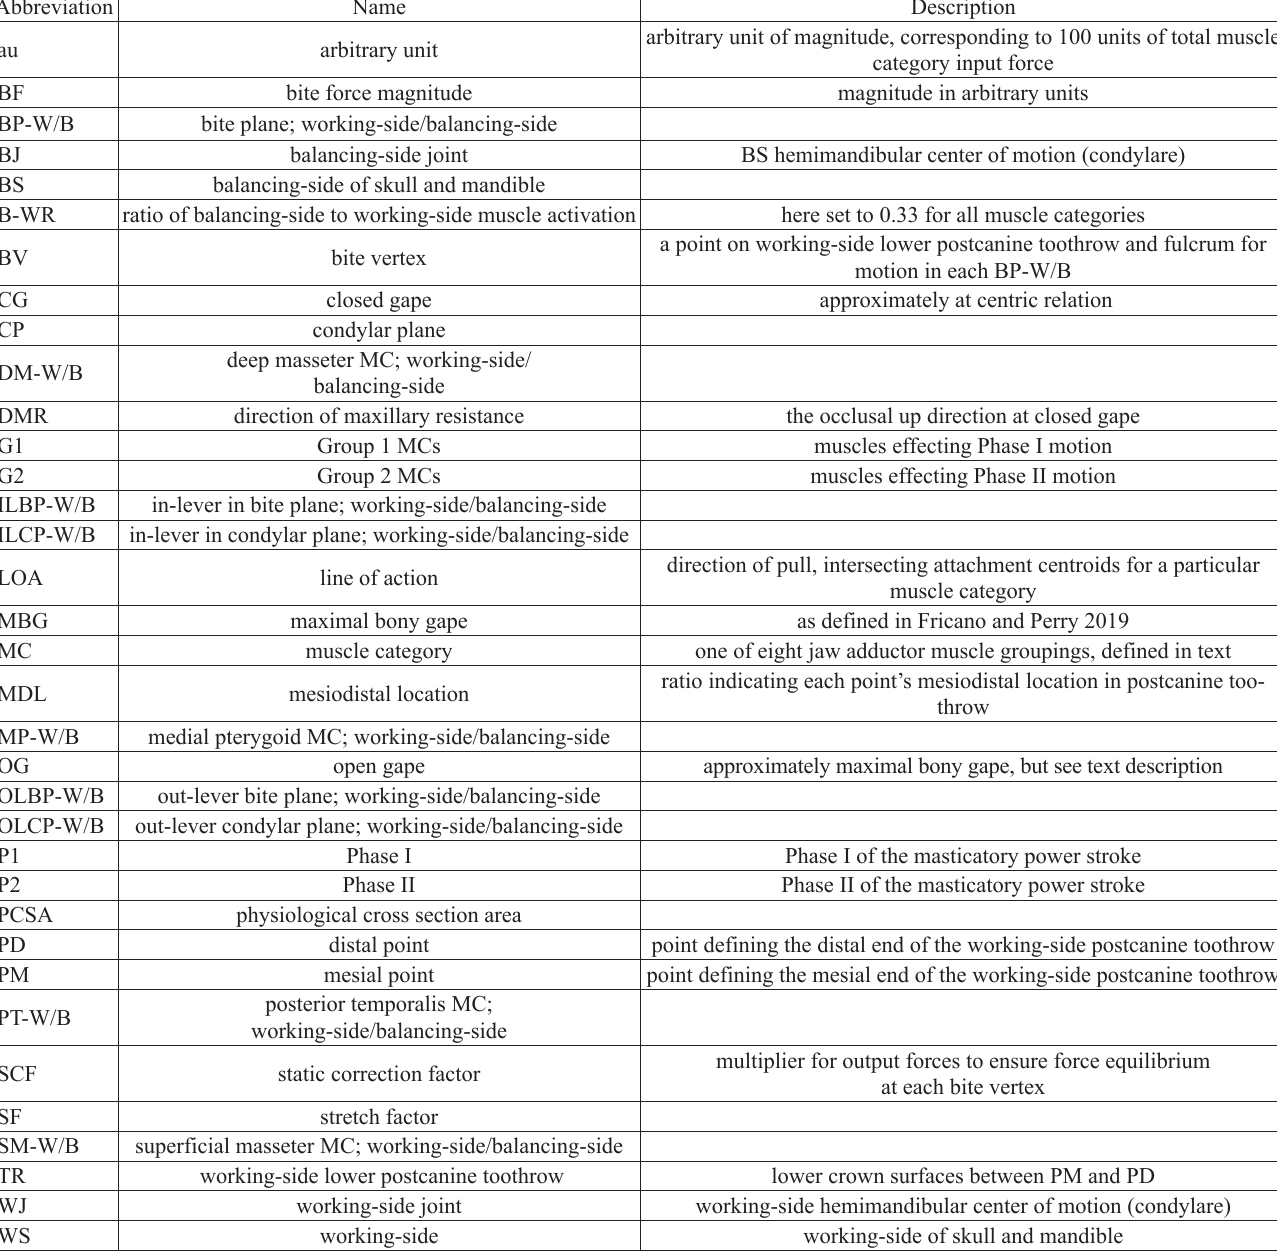
Table 1. Listing of anatomical and biomechanical abbreviations used in text Abbreviation